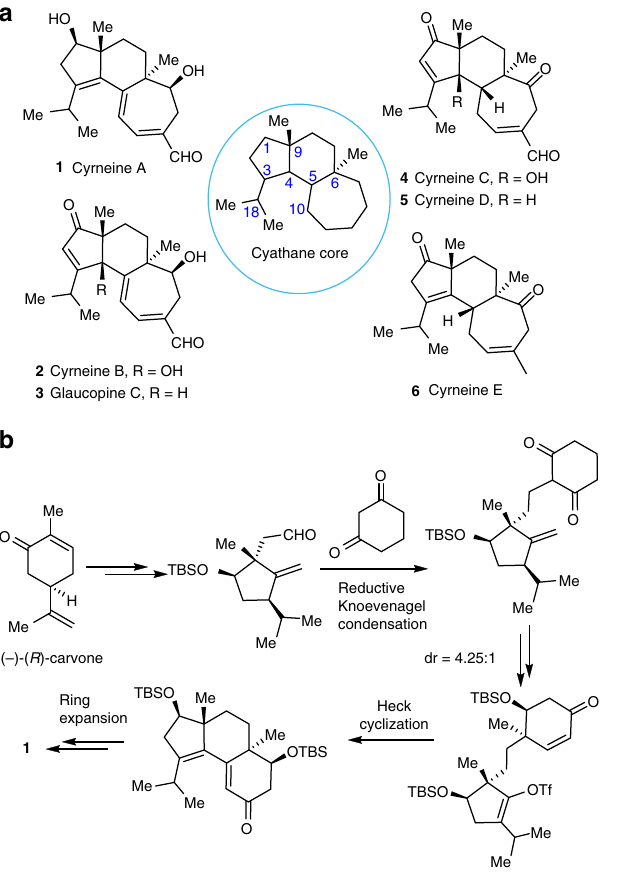
Fig. 1 Cyathane diterpenoid natural products. a The structures of cyrneines A − E and glaucopine C. The [5.6.7]-tricycle highlighted in blue circle indicates a common core structural motif shared by the natural products. b The key reactions included in Gademann ’ s synthesis of cyrneine A. Me methyl, Tf tri fl uoromethanesulfonyl, TBS tertiary -butyldimethylsilyl, dr diastereomeric ratio